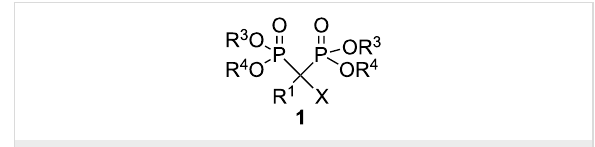
Figure 1: General structure of